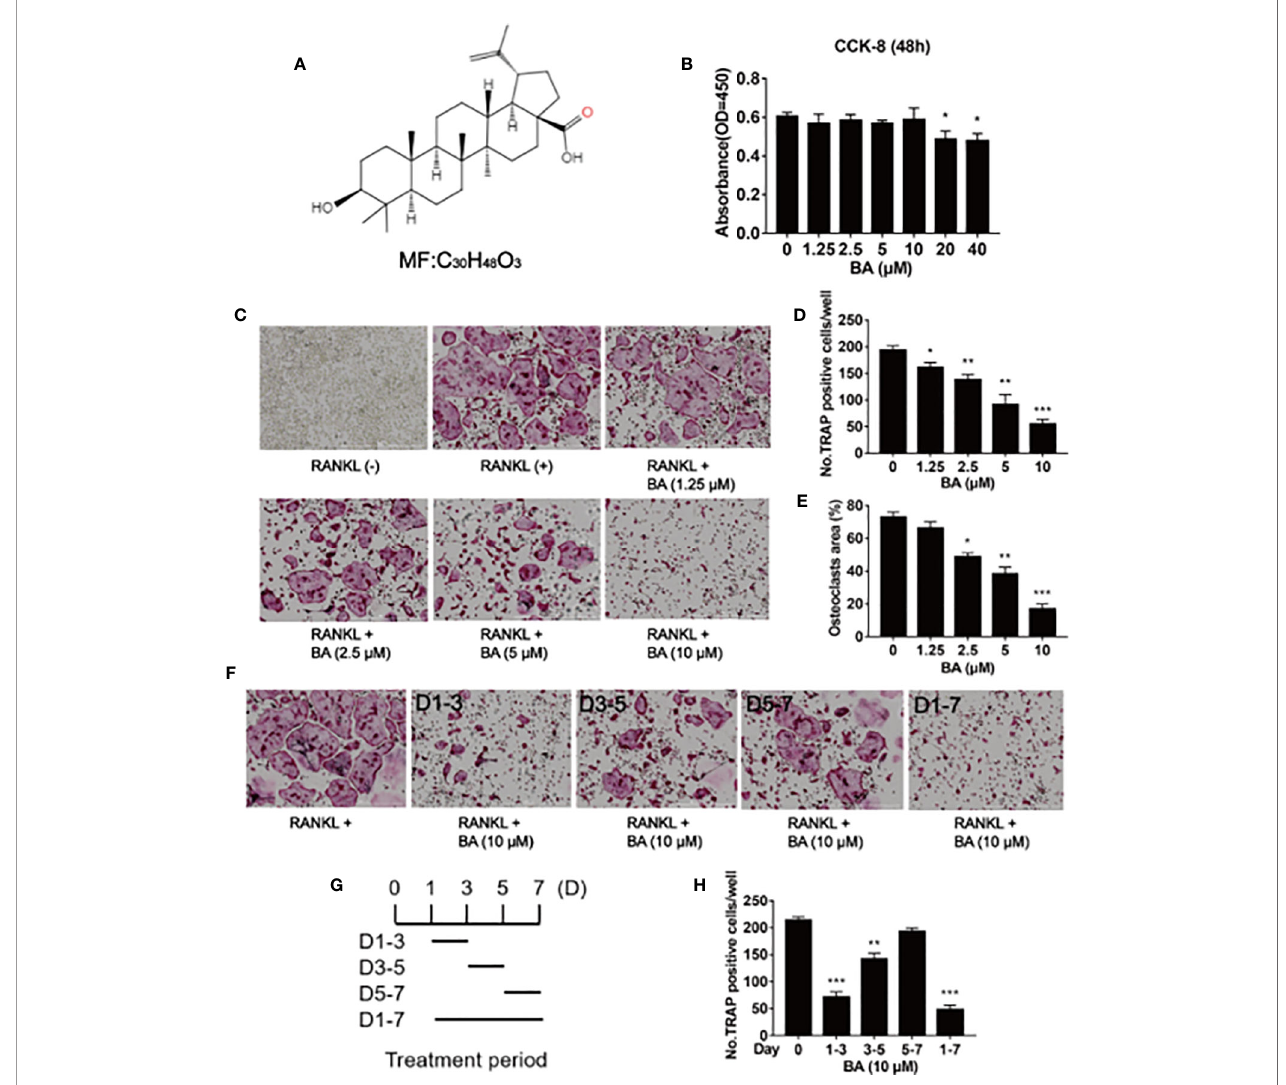
FIGURE 1 | BA inhibits RANKL-associated osteoclastogenesis in vitro . (A) Structure of BA. (B) BMM viability as assessed by CCK-8. (C) Representative micrographs of TRAP stained samples. BMMs were cultured with M-CSF (50 ng/ml) and RANKL (100 ng/ml), and administered different BA amounts for 5 days. (D, E) Quanti fi cation of TRAP-positive osteoclasts (n = 3/group). Cells showing ≥ 3 nuclei were considered osteoclasts. BA dose ‐ dependently decreased RANKL- associated OC formation. (F) Osteoclastogenesis was promoted by RANKL (50 ng/ml), and cells were administered 10 m M BA for different times. (G) Treatment times of BA. (H) TRAP ‐ positive cells showing ≥ 3 nuclei were quantitated after BA administration. Data are mean ± SD. *p <0.05, **p <0.01, ***p <0.001 vs. RANKL- induced control group (no BA administration). Scale bar = 1000 m M. BA, Betulinic acid; BMM, bone marrow macrophage; CCK-8, cell counting kit-8; RANKL, receptor activator of nuclear factor ‐ k B ligand; TRAP, tartrate-resistant acid